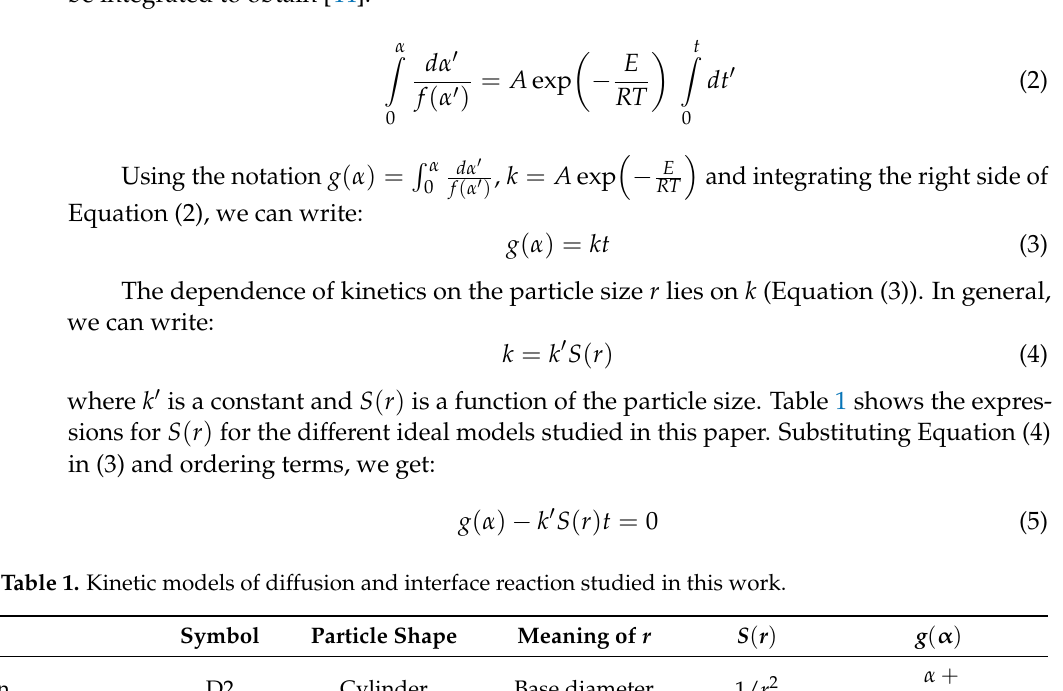
Table 1. Kinetic models of diffusion and interface reaction studied in this work. Symbol Particle Shape Meaning of r S ( r ) g ( α ) 2D diffusion D2 Cylinder Base diameter 3-D diffusion (Jander) D3 Sphere 3D diffusion (Ginstling–Brounshtein) D4 2D interface reaction 3D interface